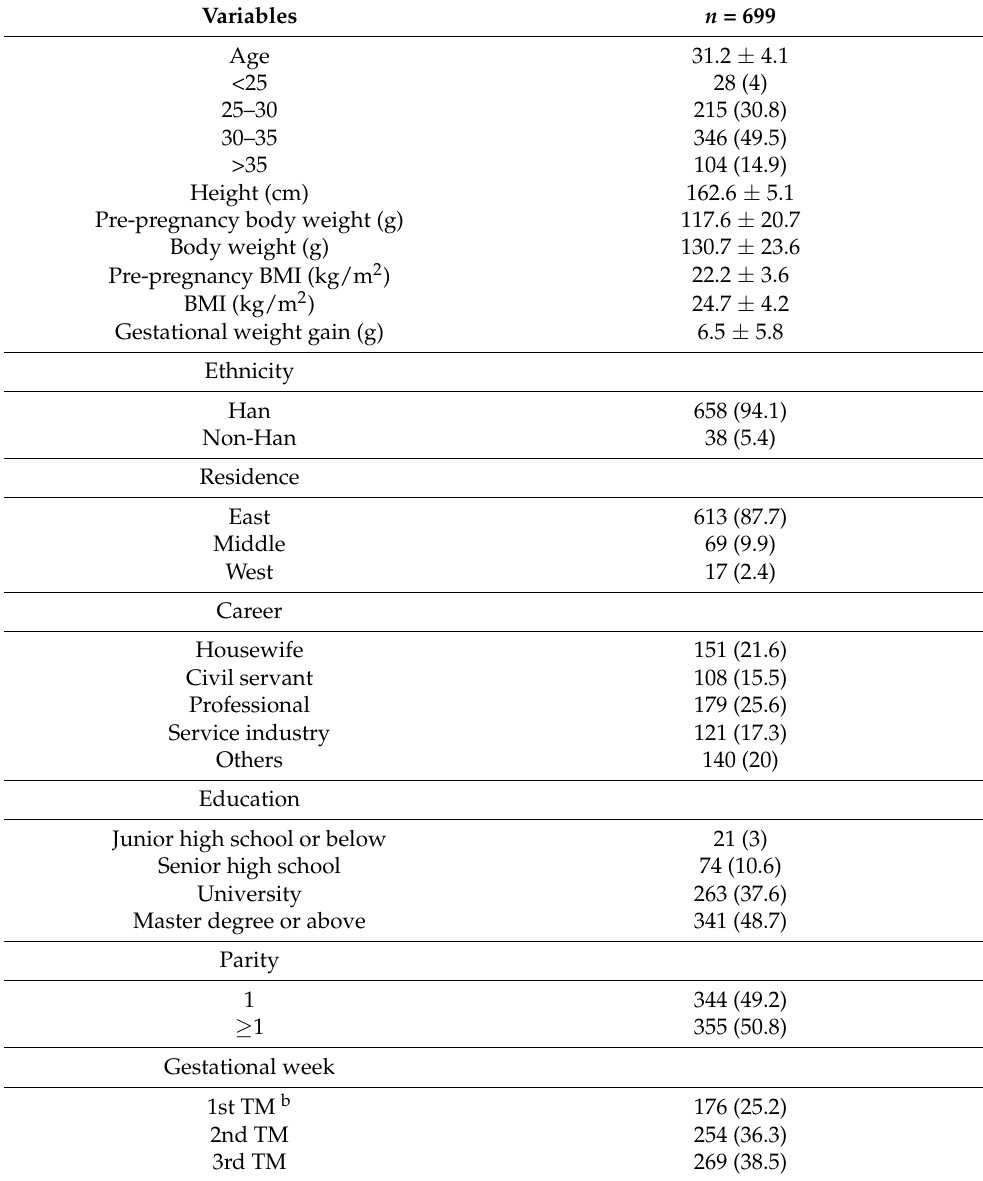
Table 3. Demographic characteristics of respondents a